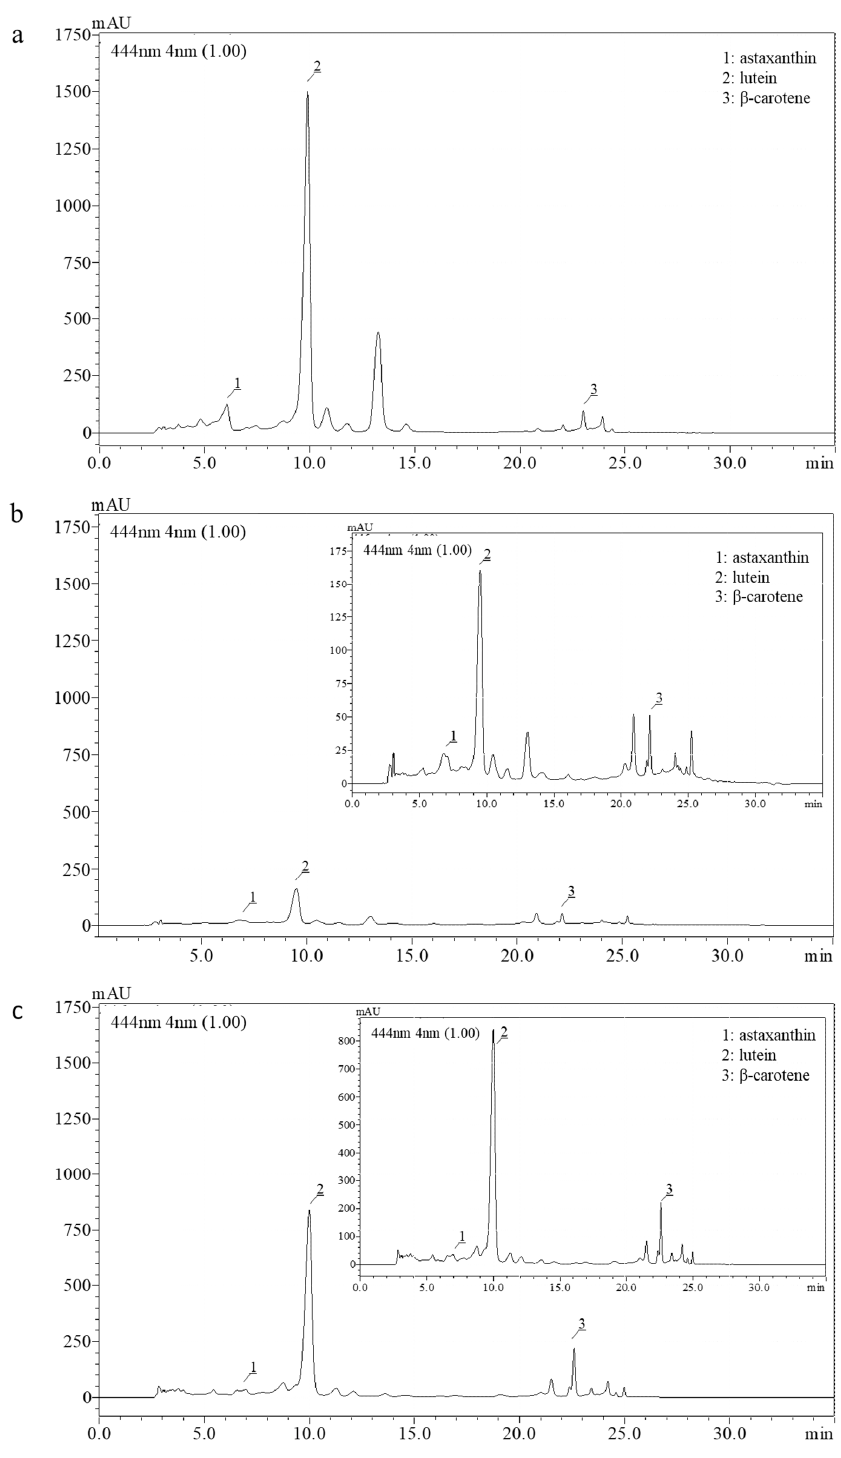
Figure 1. HPLC chromatograms of ( a ) SLE cult (concentration 7.3 mg/mL); ( b ) SLE com. (concen- tration 5.2 mg/mL) and ( c ) SFE com. (concentration 7.1 mg/mL) extracts at 444 nm. ( b , c ) include magnification of the chromatograms ( upper right ) for better viewing. The identified carotenoids are numbered and